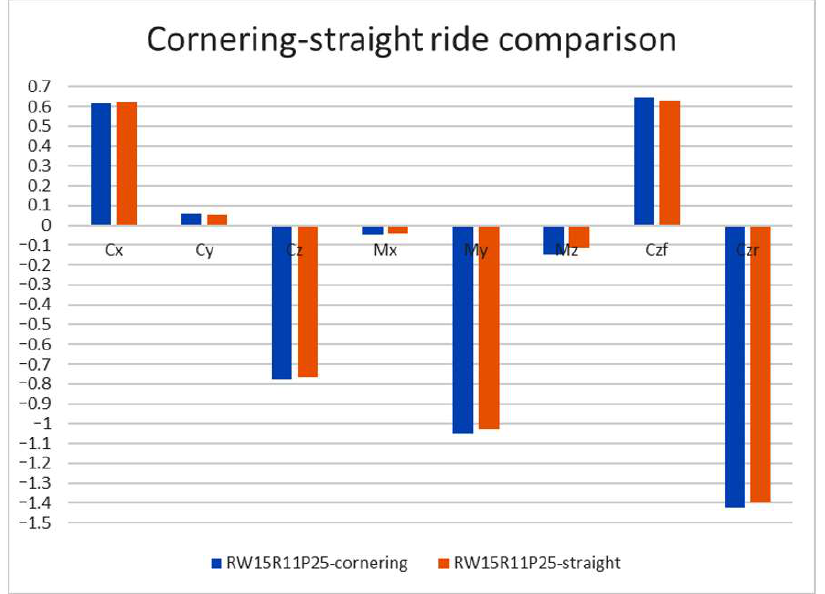
Figure 29. Comparison of vehicle characteristics in three configurations during straight and curved 90 m run.